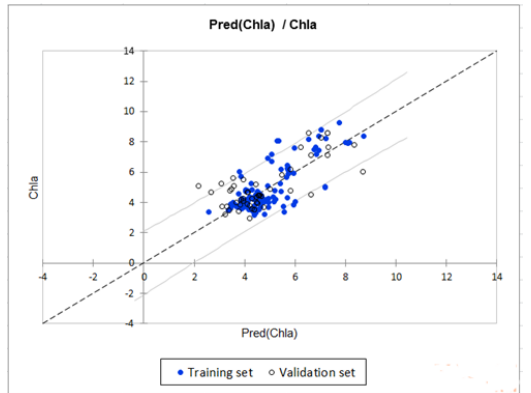
Figure 7. Graph of chlorophyll-a vs predicted chlorophyll-a